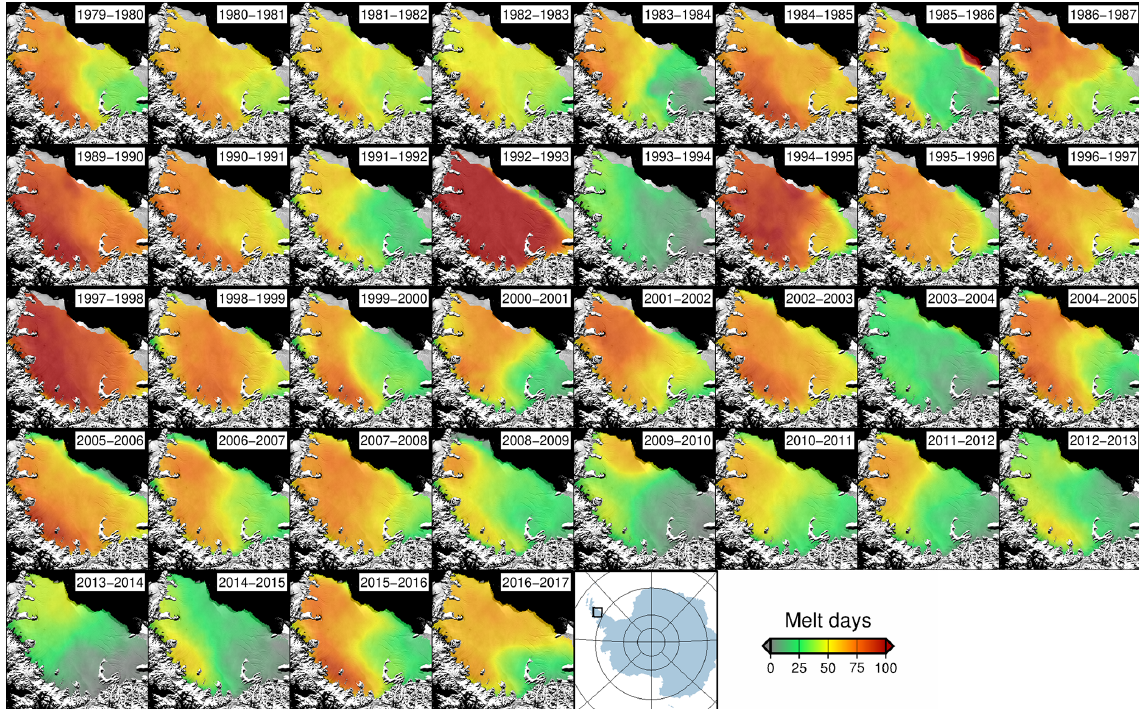
Figure A1. Time sequence of annual melt duration based on passive microwave data (SMMR, 1979–1987; and SSM/I, 1989–2017). Summers 1987/1988 and 1988/1989 are missing due to data